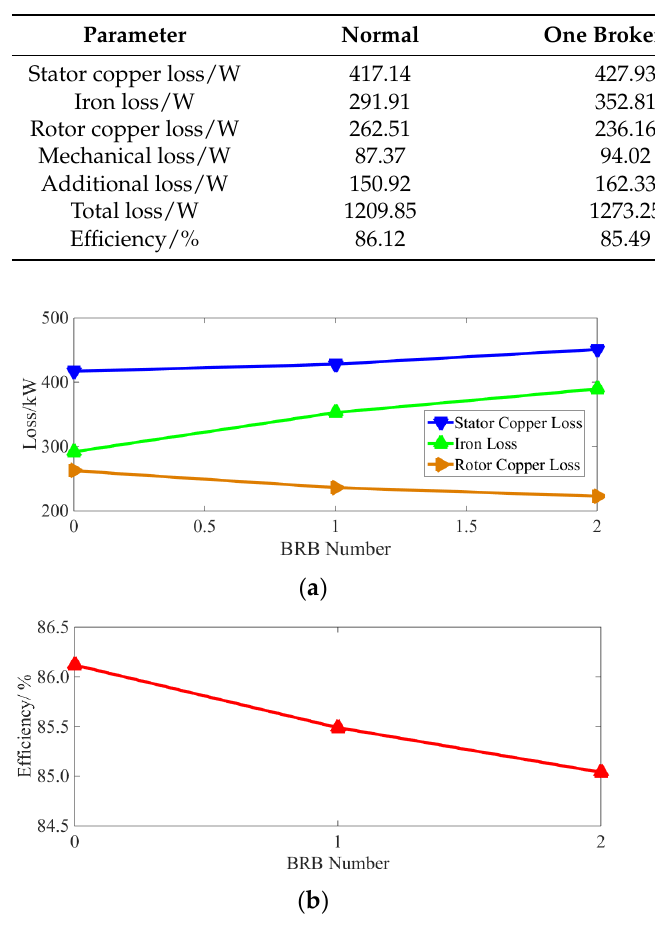
Figure 21. Extra electricity charges during the life period of the unit: ( a ) loss; ( b ) efficiency.